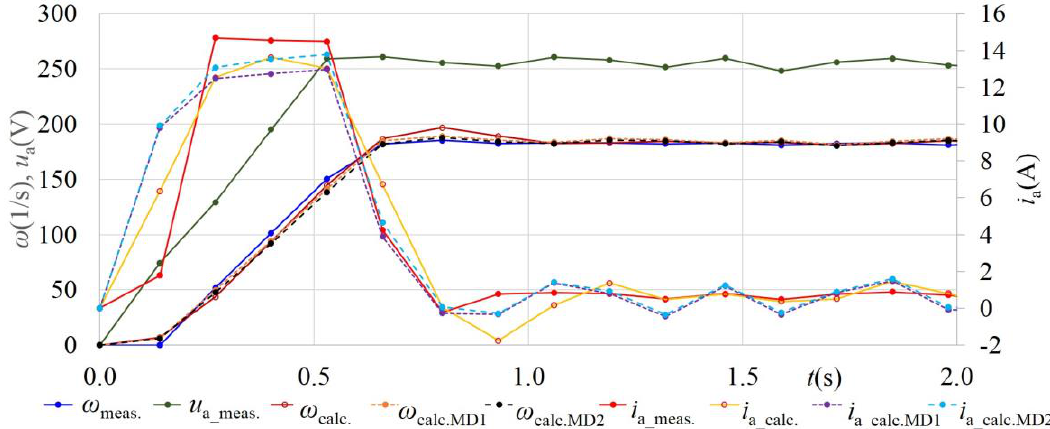
Figure 15. The simulated motor speed and current using R MD1 , R MD2 , and R MD3 for MD3 values.